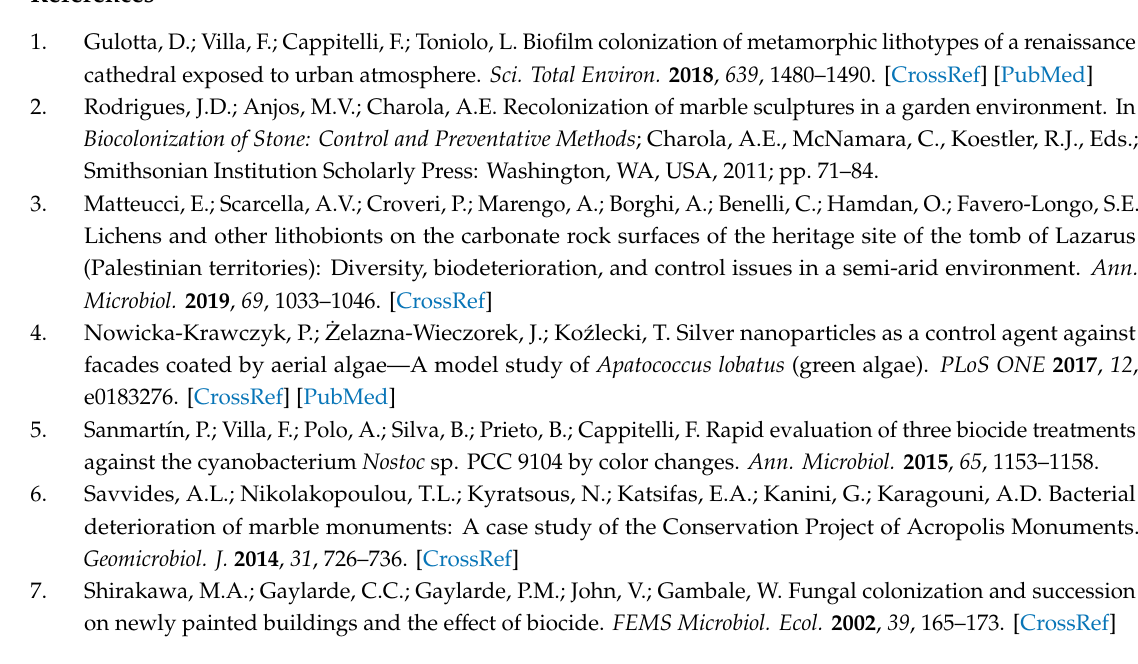
Table S1: complete list of the predicted functional diversity of both untreated and treated